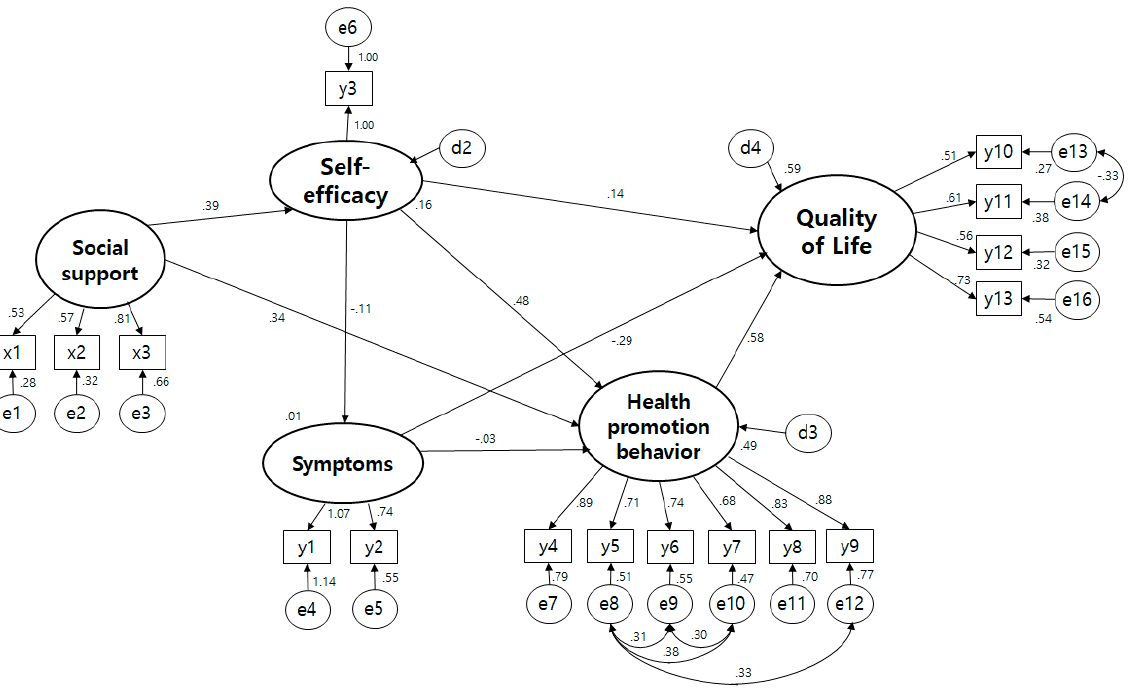
Figure 3. Path diagram modified model. x1 Sinificant support; x2 Family support; x3 Friend support;